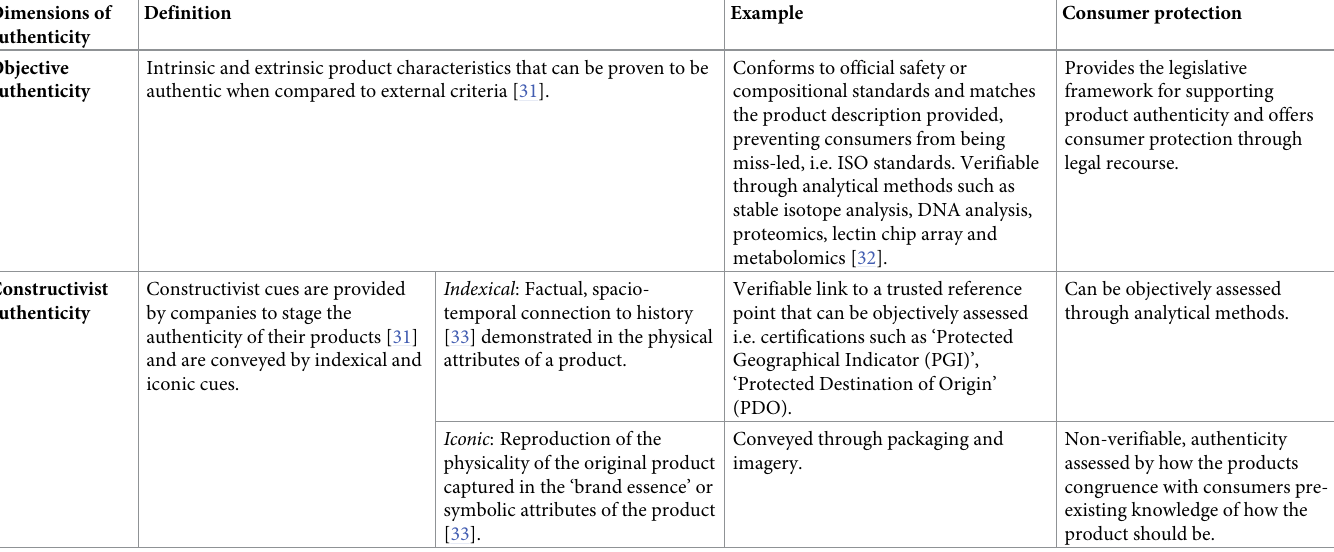
Table 1. Dimensions of